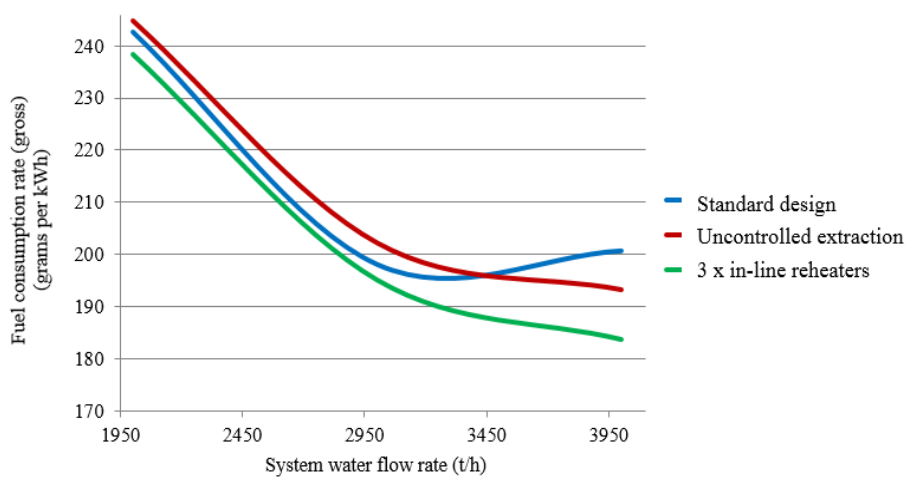
Figure 10. Plots of specific fuel-equivalent flow rates as a function of the system water flow rate for generating unit thermal systems at an outdoor air temperature of −10 °C.